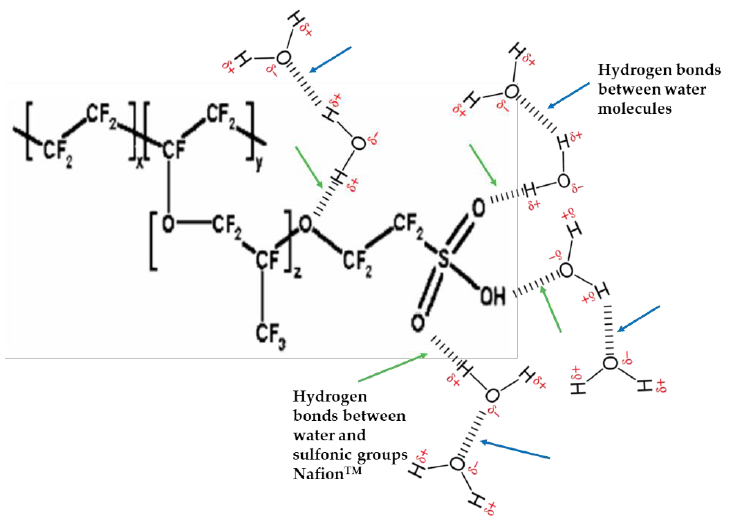
Figure 2. Nafion™ chemical structure with hydrogen bonds (sulfonic group with water molecules) Figure 2. Nafion TM chemical structure with hydrogen bonds (sulfonic group with water molecules) and hydrogen bonds (two water molecules). Modified from [55]. and hydrogen bonds (two water molecules). Modified from